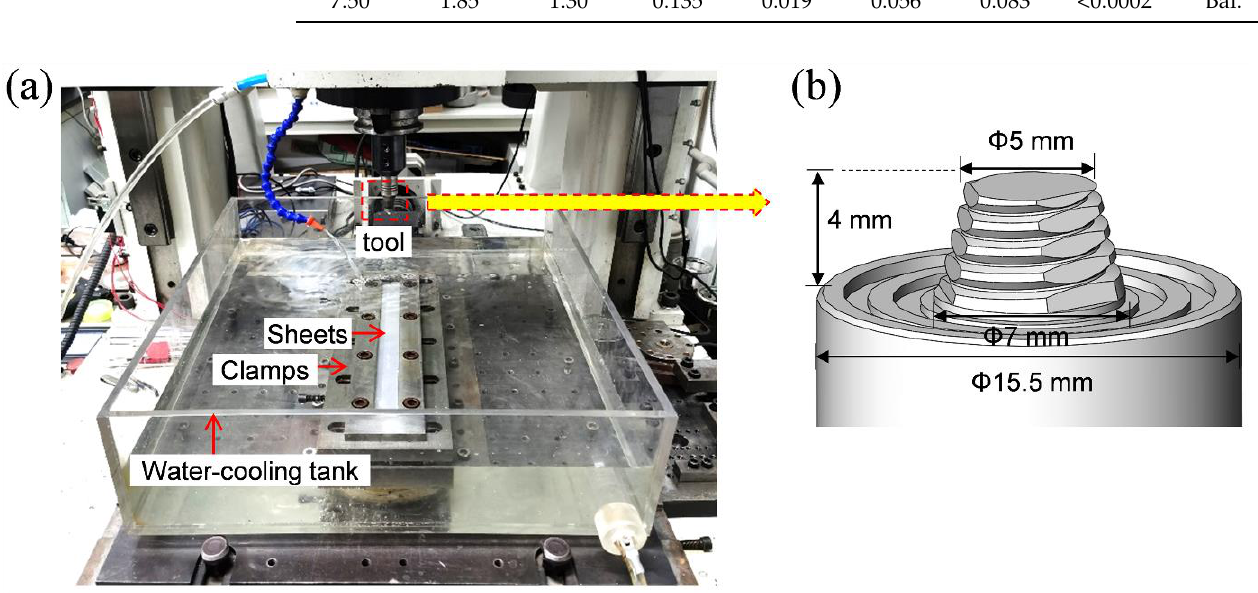
Figure 1. ( a ) Experimental setup of the underwater FSAM; ( b ) dimensions of the tool used in this